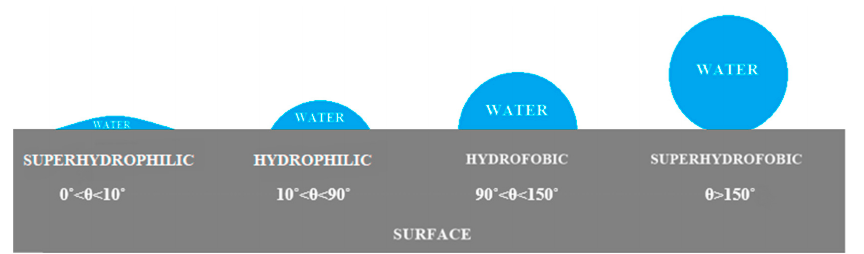
Figure 3. Categories of wettabilitybased on [59,66].